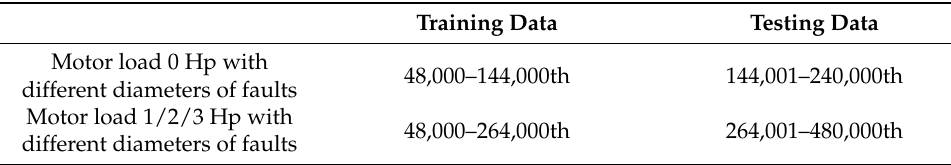
Table 2. Training Data and Testing Data.